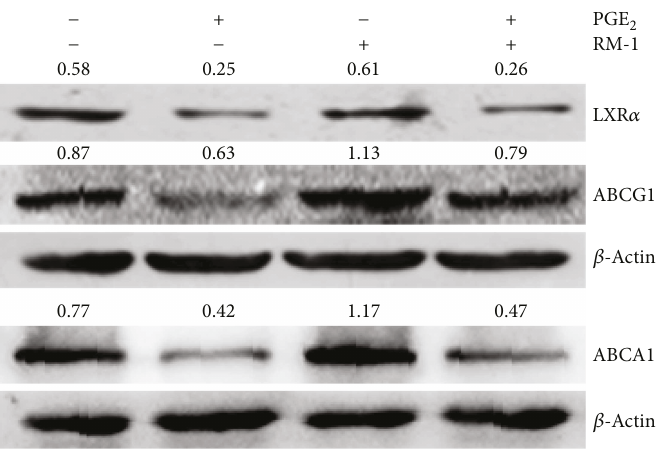
Figure 1: PGE downregulates LXR α expression and activation. The maturing DCs were cultured in the conditioned medium from RM-1. 2 The decrease in ABCG1 and ABCA1 as well as LXR α expression by PGE